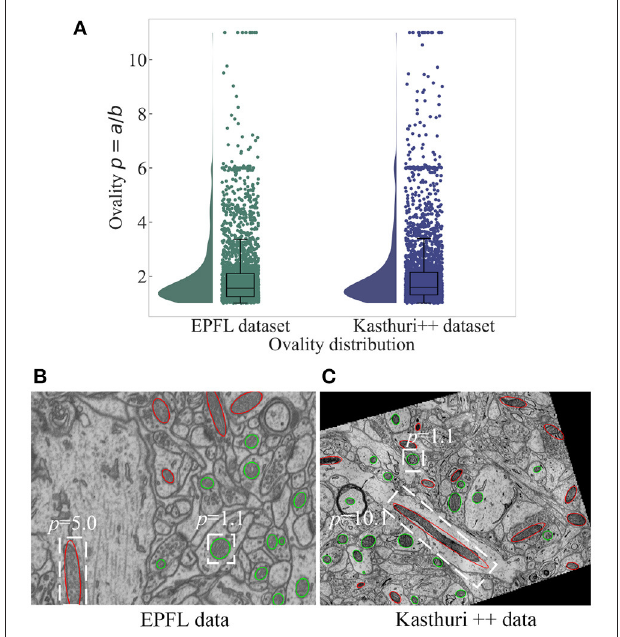
FIGURE 2 | The ovality distribution of mitochondria on images from the EPFL dataset and the Kasthuri++ dataset. The ovality p of each mitochondrion is defined as the ratio of the length of its major axis a to the length of its minor axis b , which can be obtained by performing ellipse fitting on the label maps. The median of ovality p distribution (A) is 1.56 on the EPFL dataset and 1.60 on the Kasthuri++ dataset. The red contours in (B,C) represent mitochondria with p over 1.60, and the green contours represent those with p lower than